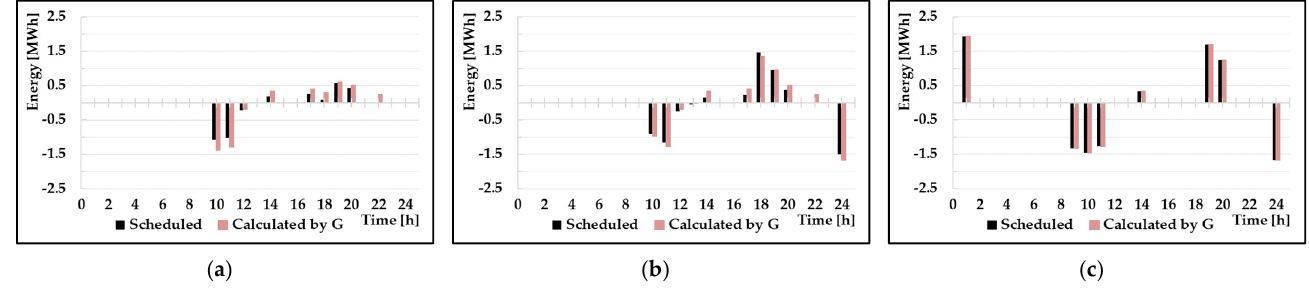
Figure 11. Charging/discharging patterns for Scenario C using methods ( a ) I 70 , ( b ) I 80 , and ( c ) II.